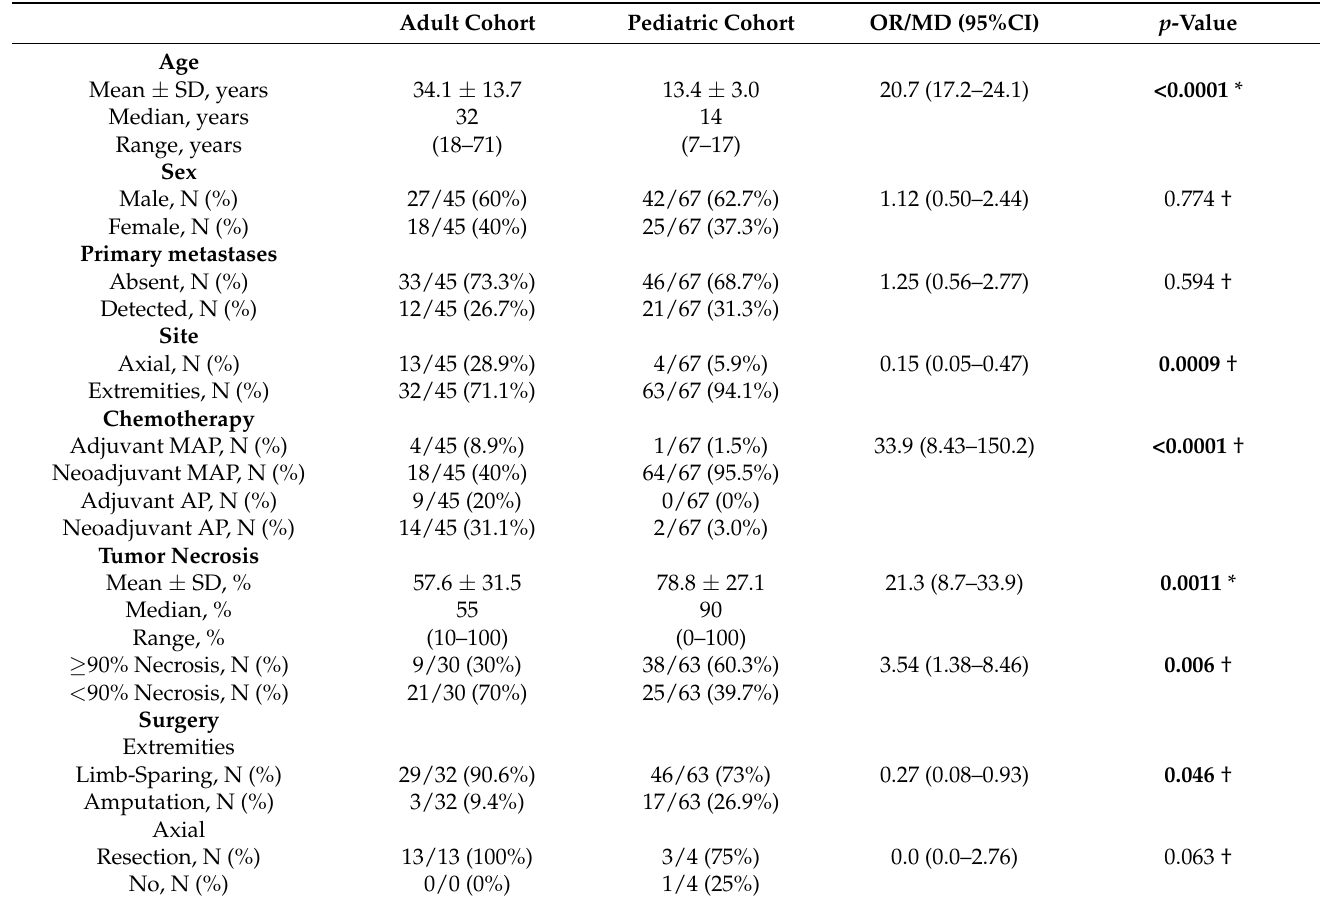
Table 1. Adult cohort vs. pediatric